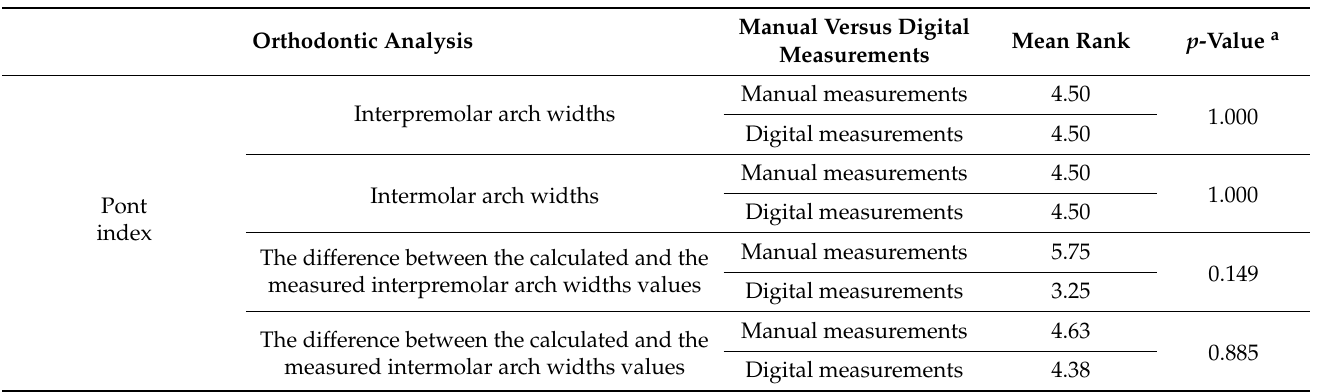
Table 5. Manual versus digital measurement comparison of the analyzed indices using the Mann– Whitney U